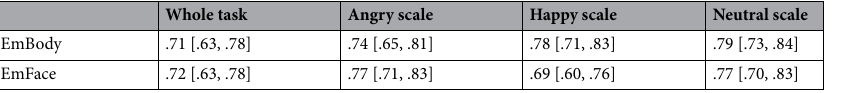
Table 4. Retest reliability of the EmBody and the EmFace as intraclass correlation coefficients (ICC) for raw hit rates. ICCs use the two-way mixed effects model, type absolute agreement, average measurement. 95% confidence intervals (95% CI) for each ICC are reported in square brackets. For comparison, the ICC computed for RMET scores was .73 [.65, .79].